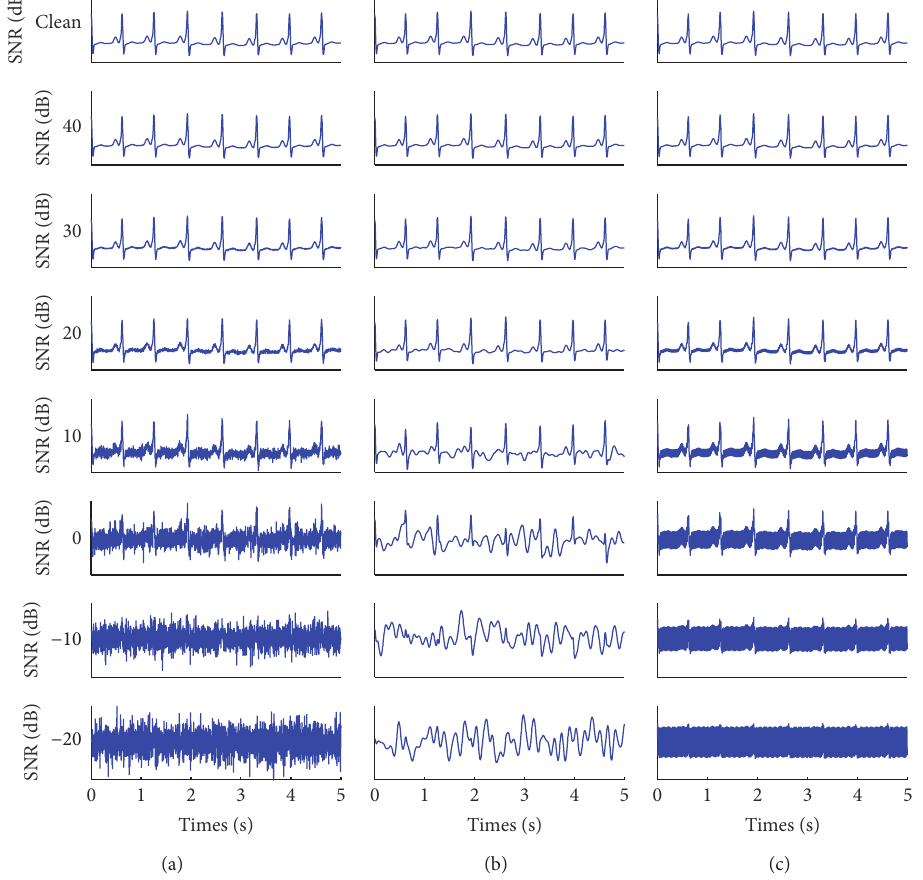
Figure 1: The clean artificial ECG and the clean ECG added noises with different SNRs from − 20 dB to 40dB, with a step of 10 dB. (a) The clean ECG and the clean plus HF noise. (b) The clean and the clean plus LF noise. (c) The clean and the clean plus PL noise.